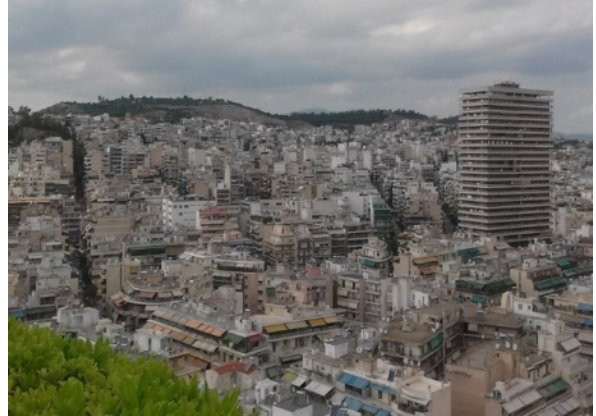
Figure 5: General outlook of ‘’Apollon” towards Tourkovounia